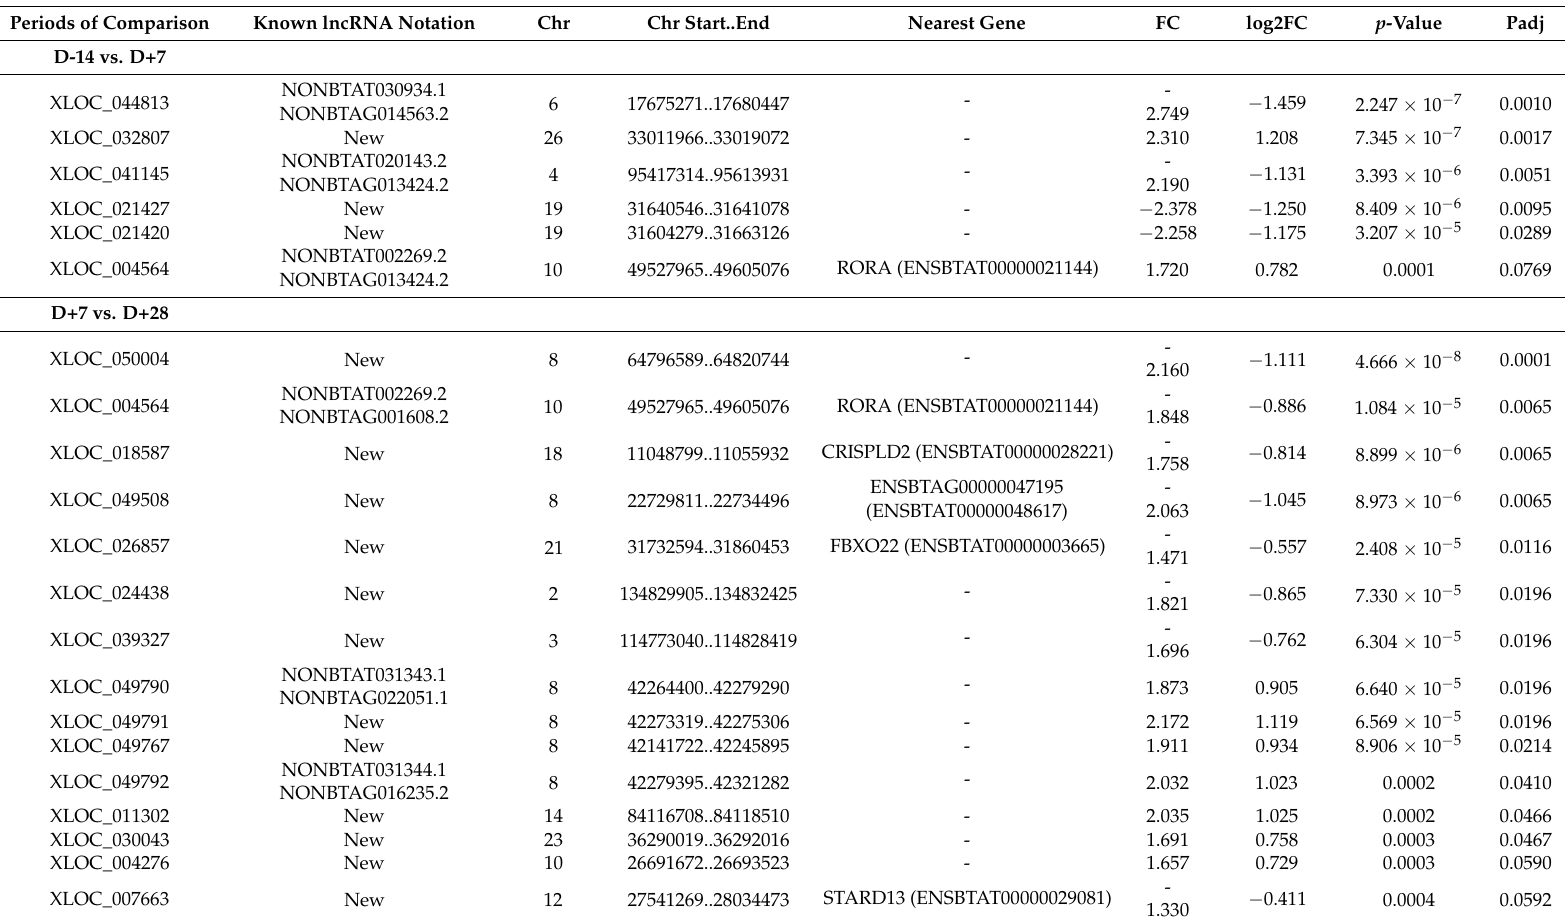
Table 3. Differentially expressed lncRNAs in response to dietary supplementation with 5% linseed